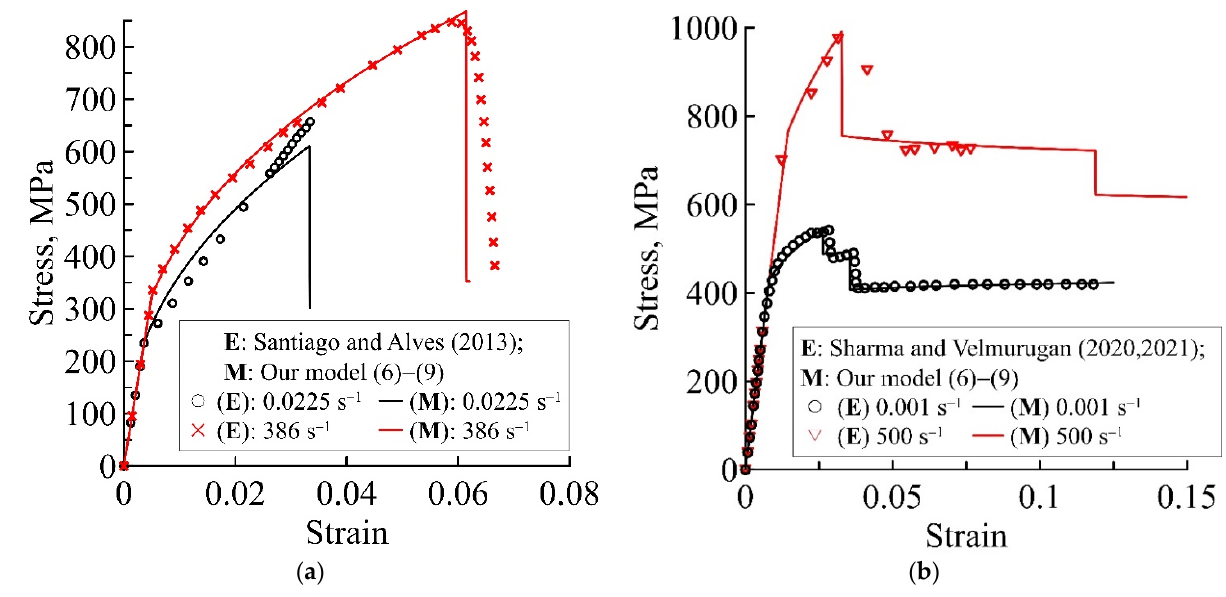
Figure 2. Predicted static and dynamic deformation curves of Me/GFRP/Me/GFRP/Me laminates using the proposed model (6)–(9), marked by solid lines, with different total thickness ratios of metal and polymer layers: ( a ) 1.2 and ( b ) 0.62. Experimental static and dynamic deformation curves for ( a )